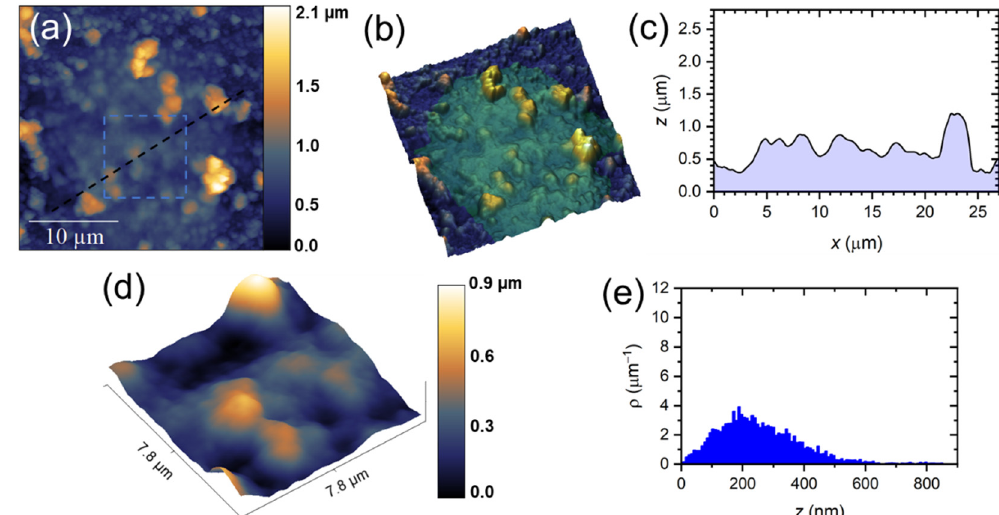
Figure 2. Representative AFM image of an acute lymphoblastic leukemia cell cultured on the TiO 2 -m coating for 10 min. ( a ) Two-dimensional and ( b ) three-dimensional topography images. The green mask in ( b ) indicates the expanse of the cell membrane. ( c ) Height profile taken along the dashed line in ( a ), revealing that the cell adopts the underlying surface topography. ( d ) Three-dimensional representation of the zoomed area indicated by the dashed square in ( a ). ( e ) Height distribution function calculated for the zoomed image shown in ( d ). The height z = 0 nm corresponds to the lowest height value within the zoomed region in ( d ).